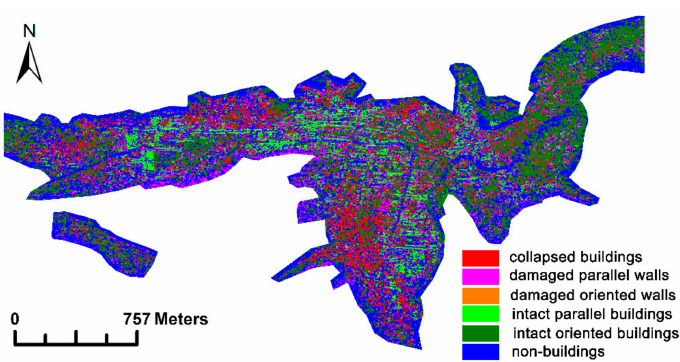
Figure 8. Extraction results for the five kinds of buildings and non-buildings in the earthquake-stricken urban area of Yushu